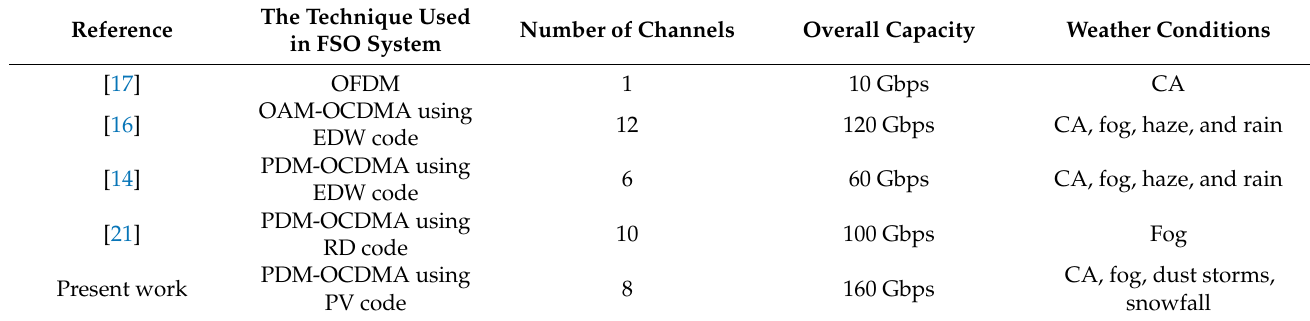
Table 7. Comparison between present work and previous recent